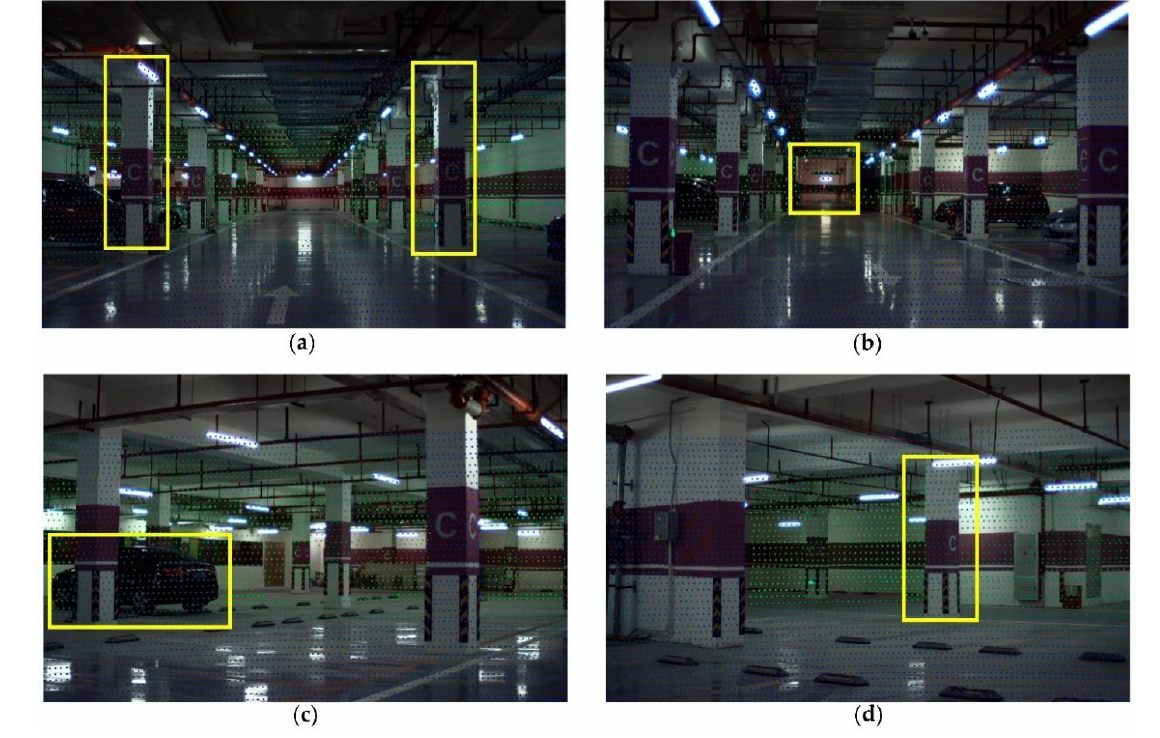
Figure 16. Results of outdoor scene test, θ = 0.4 ◦ . The contents in yellow rectangles in ( a – d ) are projections at different distances.